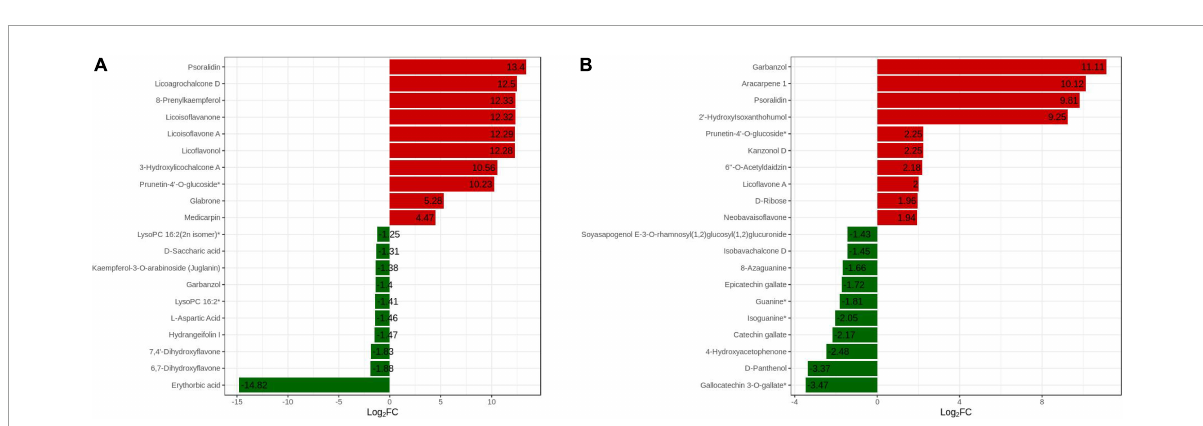
FIGURE8 Dynamic distribution of differences in metabolite content in the TOP20. The abscissa is the log2FC of the differential metabolites, and the ordinate is the differential metabolites. Red represents up-regulated differential metabolites and green represents down-regulated differential metabolites. (A) HN44 group; (B) HN65